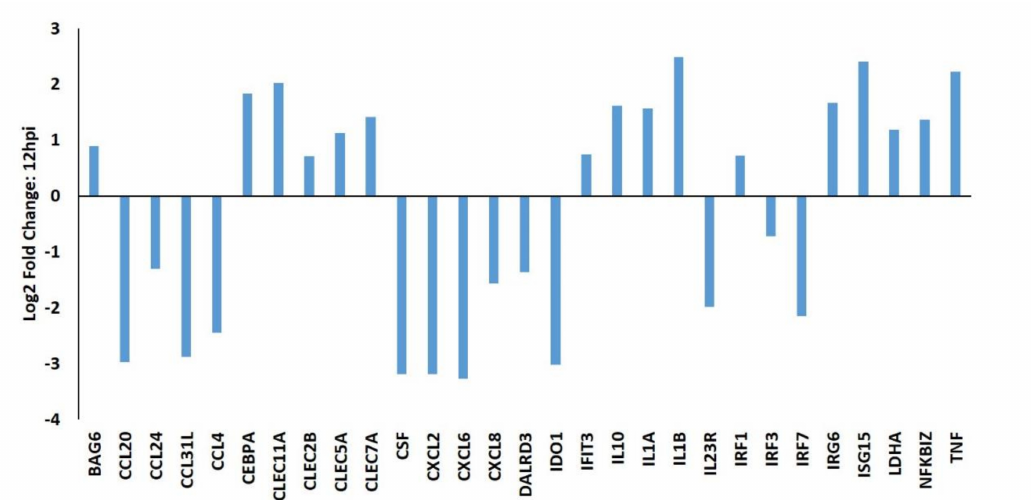
Figure 1. A selection of di ff erentially expressed genes in PRRSV-infected macrophages at 12 h post infection (hpi). PAMs ( n = 3) were either infected with PRRSV strain VR-2332 or mock infected and total RNA was collected at 12 h and subjected to RNA-sequencing. All values are provided as the log 2 fold di ff erences of gene expression levels in PRRSV-infected PAMs relative to mock-infected PAMs. All genes shown were statistically significantly di ff erent false discovery rate (FDR)-corrected p < 0.05 between the groups.